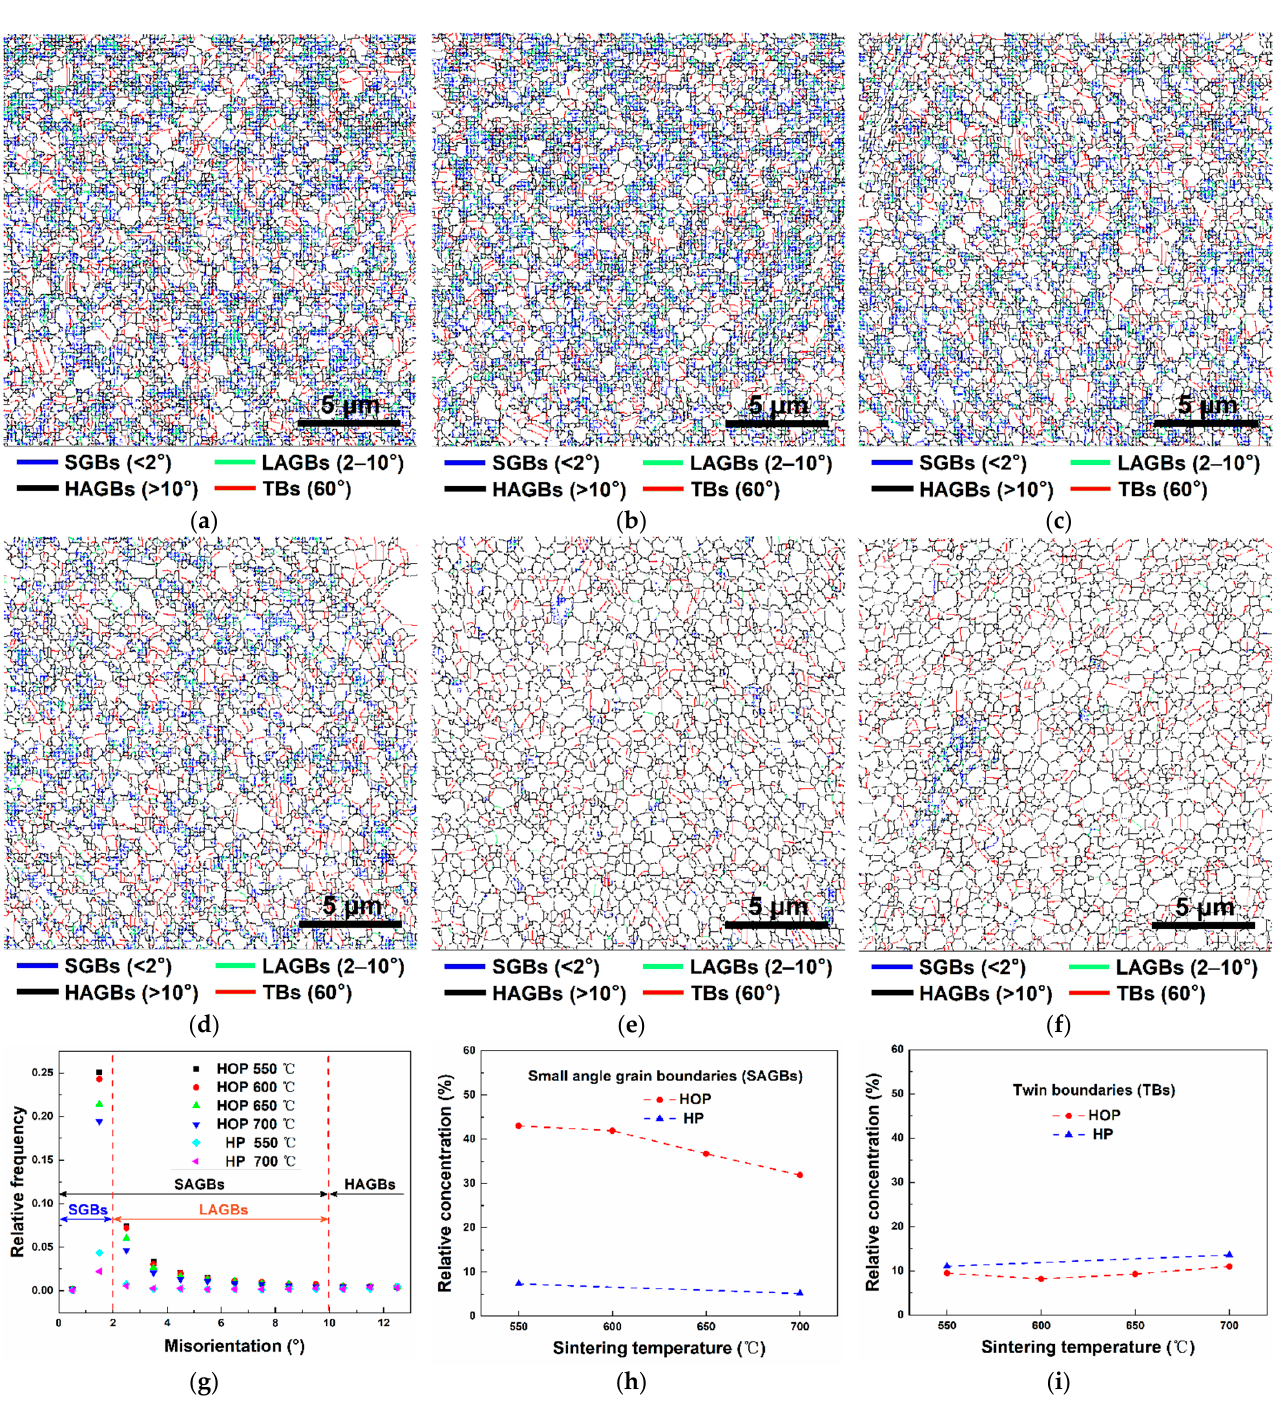
Figure 6. ( a – f ) EBSD maps of grain boundary for samples prepared by ( a ) HOP at 550 °C, ( b ) HOP at 600 °C, ( c ) HOP at 650 °C, ( d ) HOP at 700 °C, ( e ) HP at 550 °C, and (f ) HP at 700 °C, respectively. ( g ) Probability distribution of grain boundaries as a function of misorientation angles for sintered samples. ( h , i ) Relative concentration of small–angle grain boundaries and twin boundaries as a function of sintering temperature, respectively, for samples sintered by HOP and HP, respectively.